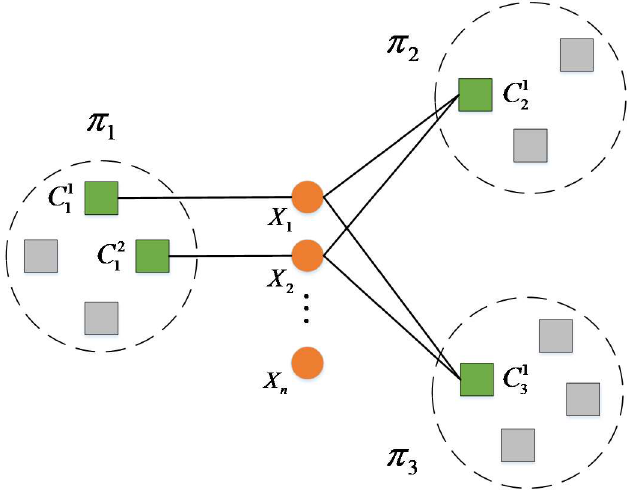
Figure 4. Application of Connected Triple in clustering ensemble.